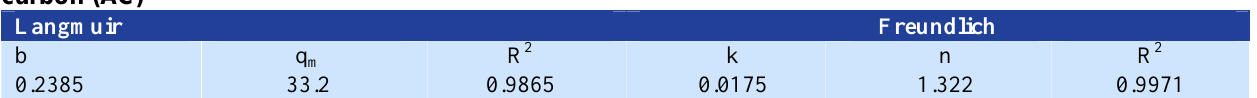
Table 3. Parameters of Langmuir and Freundlich models in adsorption of humic acid (HA) on activated carbon (AC) Langmuir